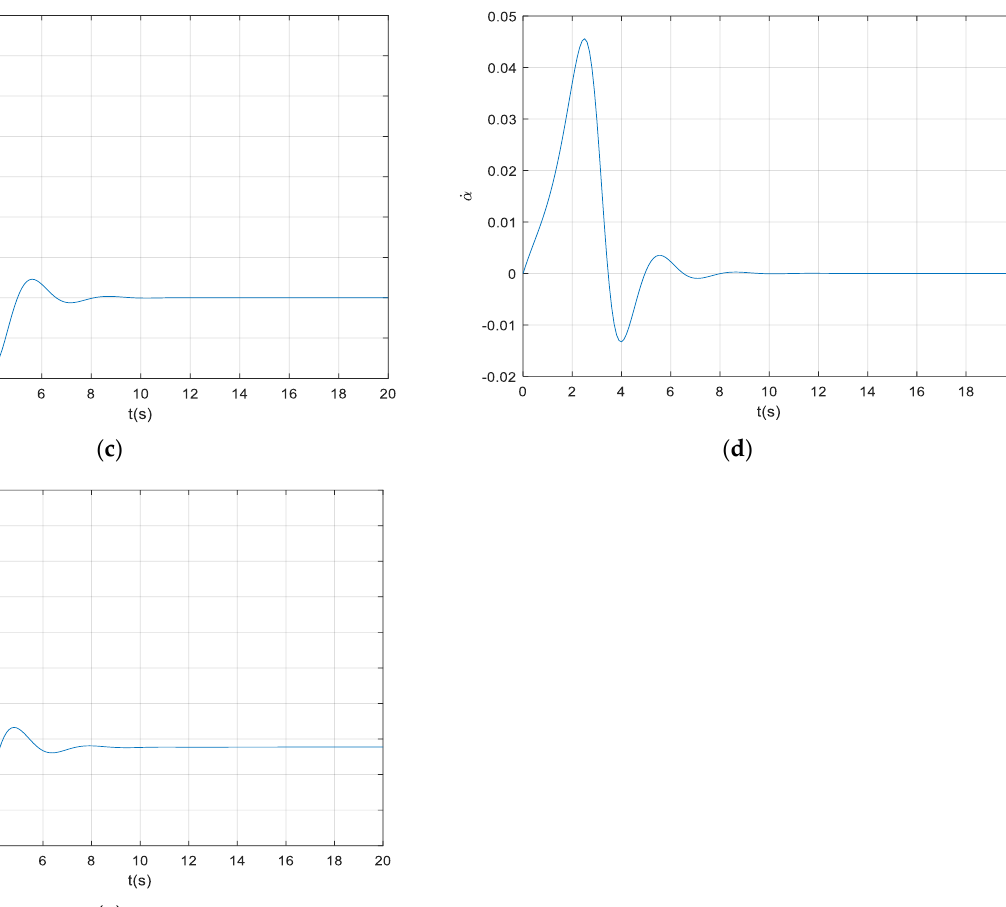
Figure 6. Nominal NDI for HFV under modeling error. ( a ) Tracking curve of the normal overload Nys. ( b ) Tracking curve of pitch rate derivative Tracking curve of the attack angle derivative